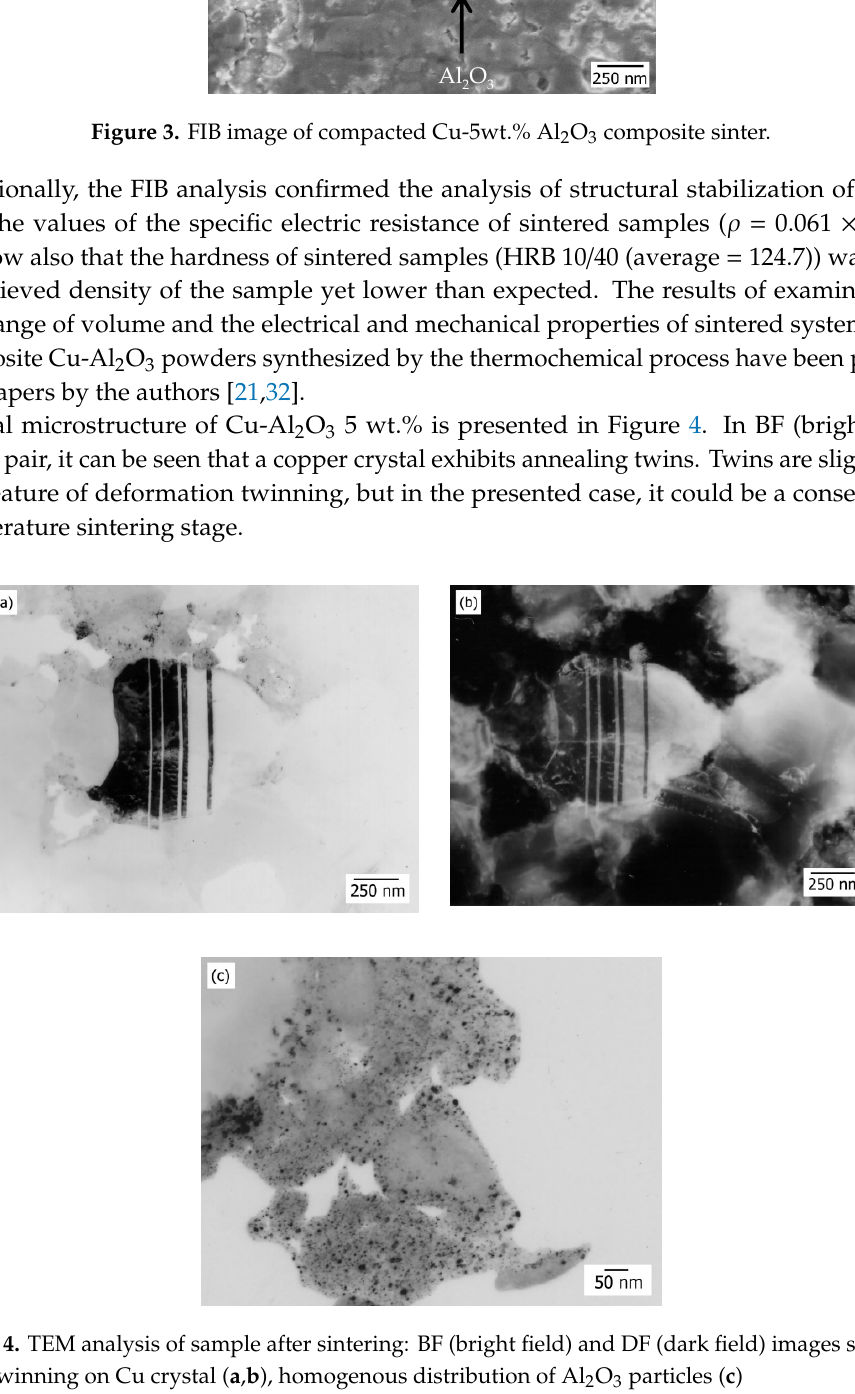
2 O 3 composite sinter.